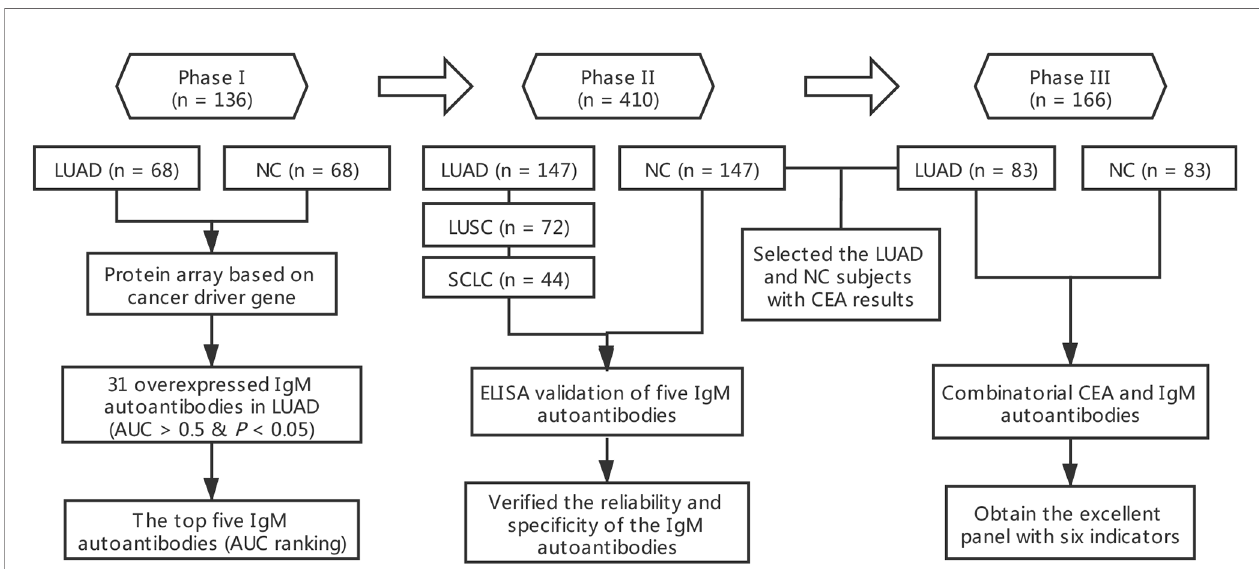
FIGURE 1 | Overall design of this study. AUC, area under the receiver operating characteristic curve; CEA, carcinoembryonic antigen; LUAD, lung adenocarcinoma; LUSC, lung squamous cell carcinoma; NC, normal control; SCLC, small cell lung carcinoma.